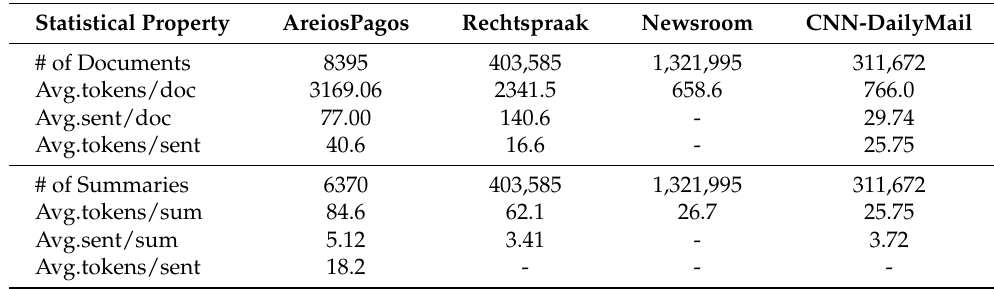
Table 3. Statistical properties of the text summarization dataset using the average ratios of token- level lengths for documents and summaries and their sentences. AreiosPagos and Rechtspraak are legal Court case text datasets, while Newsroom and CNN-DailyMail are news domain sum- marization datasets. The results on the Newsroom dataset are reported from [17]. The results on the CNN-DailyMail and Rechtspraak datasets are reported from [31]. The upper part of the table presents statistics on the judgments’ main texts, while the lower part presents the statistics on the judgment